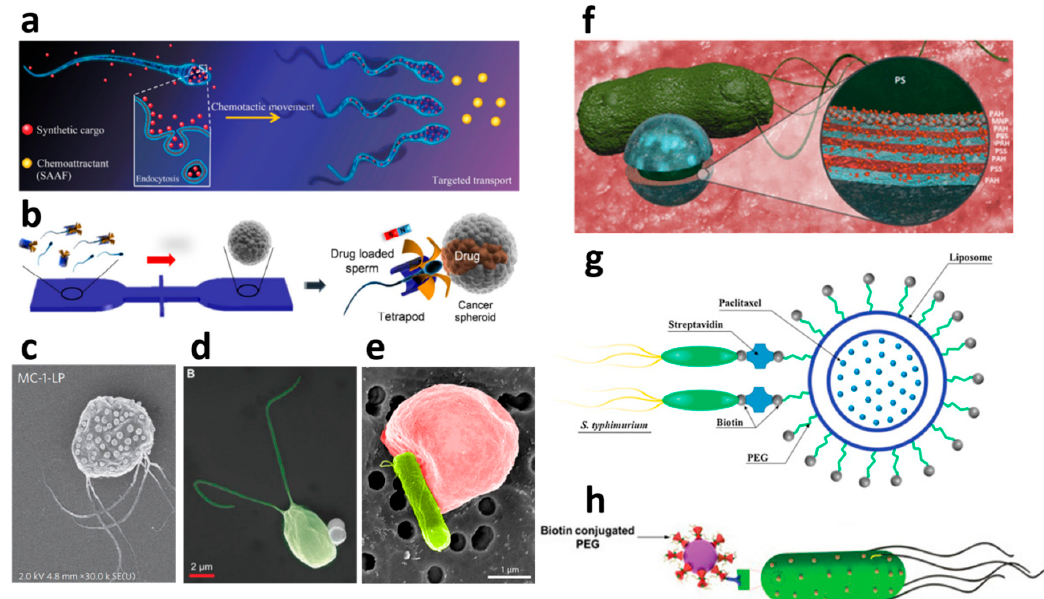
Figure 3. Biological propulsion units for anti-cancer therapy by nano-and micromotors: ( a ) Figure 3 . Biological propulsion units for anti-cancer therapy by nano-and micromotors: a )